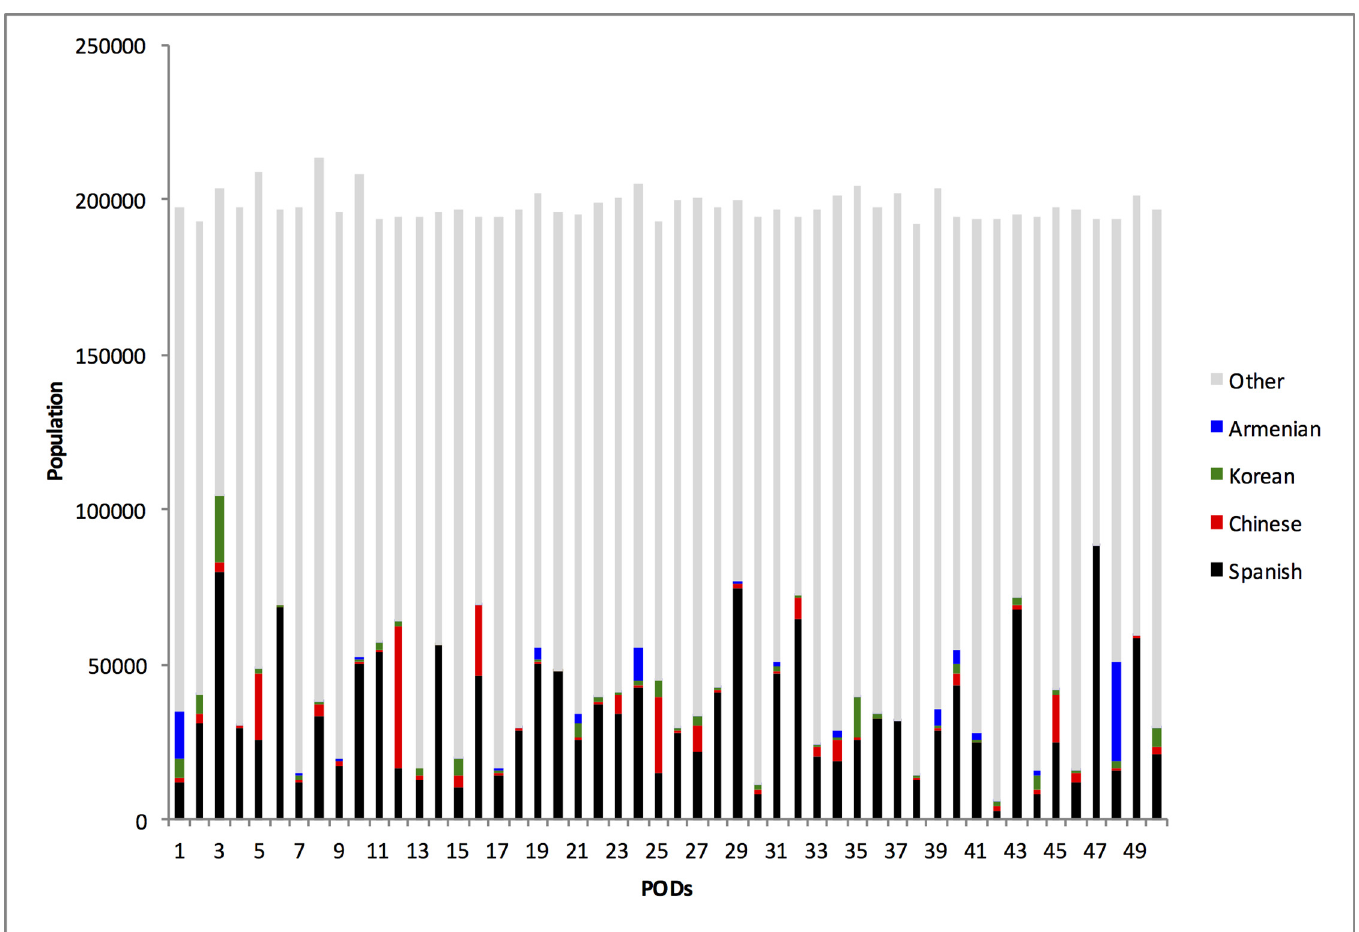
Fig 9. Language Vulnerability. Vulnerable Chinese, Korean, Spanish and Armenian sub-populations in each service area compared to the total population in the service area.